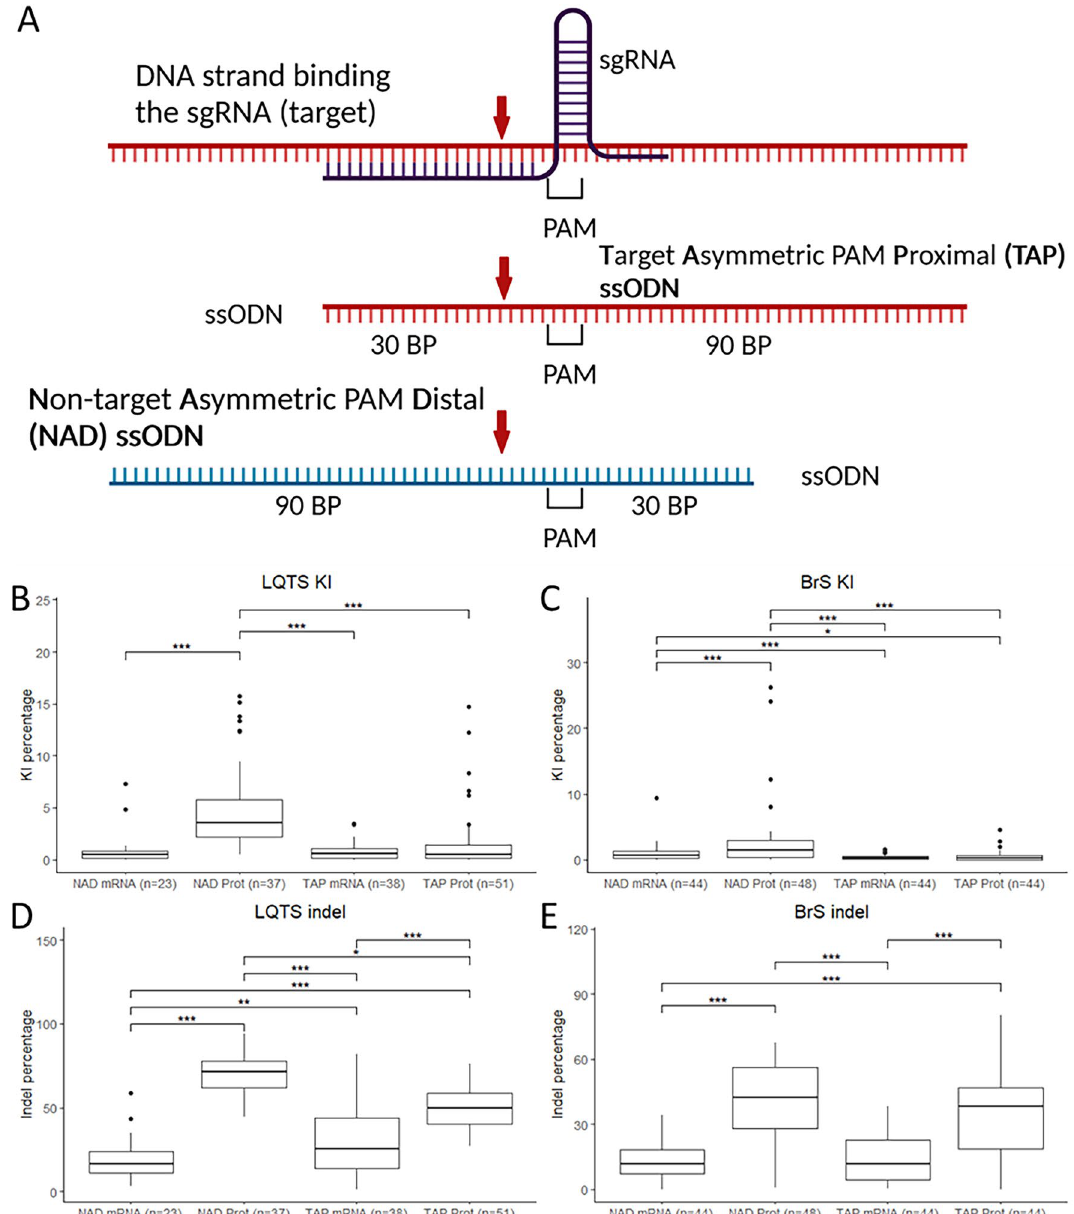
Figure 2. Editing efficiency with different injection components. ( A ) ssODN conformations used for the experiments, red arrow: CRISPR-Cas9 cut site. ( B,C ) KI efficiencies with the different ssODN conformations and Cas9 protein/mRNA for the LQTS locus ( B ) and the BrS locus ( C ). ( D,E ) Indel percentages with the different ssODN conformations and Cas9 protein/mRNA for the LQTS locus ( D ) and the BrS locus ( E ). Statistical testing was performed with negative binomial regression with use of the Tukey’s HSD (honestly significant difference) test for multiple correction, not significant results are not displayed, ***p-value < 0.001, **p-value < 0.01, *p-value < 0.05. PAM protospacer-adjacent motif, BP base pairs, NAD non-target asymmetric PAM distal, TAP target asymmetric PAM proximal, KI knock-in, indel